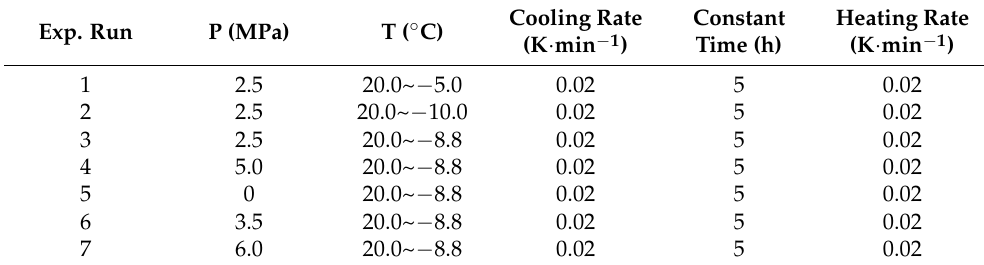
Table 1. Temperature procedure in DSC